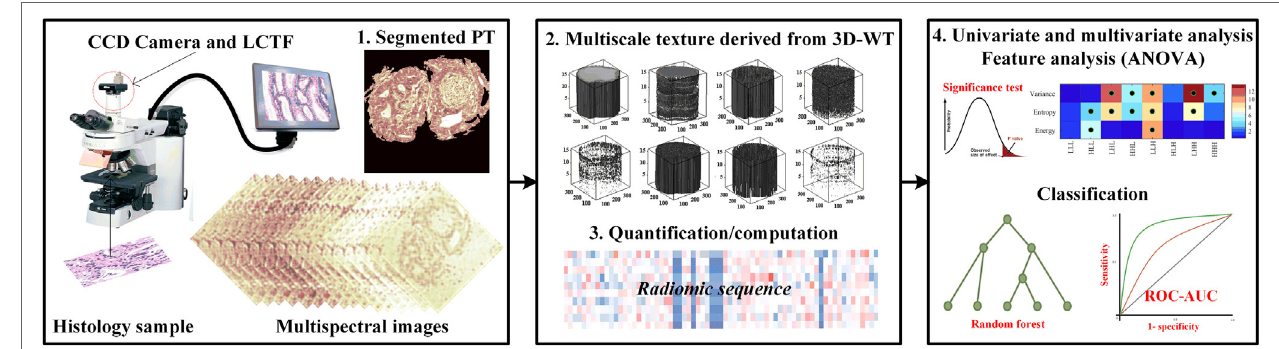
FigUre 1 | The proposed pipeline for identifying colorectal cancer (CRC) histopathology [i.e., stroma, benign hyperplasia (BH), intraepithelial neoplasia, and carcinoma] using multiscale texture features derived from multi-spectral images. Preprocessing steps consists of biopsy sample preparation, data acquisition from optical microscopy system, then segmentation of sections using the active contour model. Multiscale texture was derived from segmented pathology tissue using 3D-wavelet transform. Texture was quantized by three quantifier functions (i.e., variance, entropy, and energy). Univariate and multivariate analysis was performed using ANOVA significance test and random forest classifier model to distinguish between malignancy